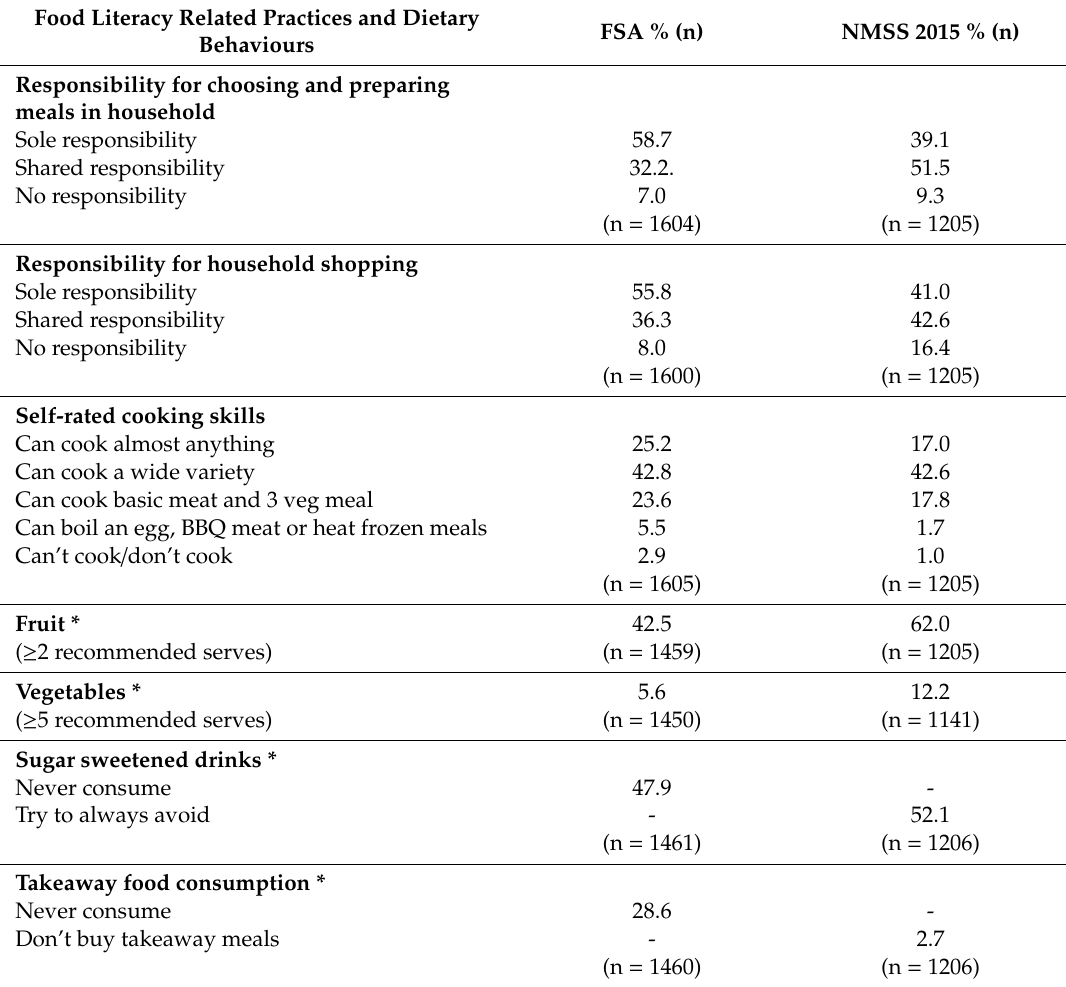
Table 2. Food literacy related practices and dietary behaviours compared to Western Australian Department of Health’s Nutrition Monitoring and Surveillance Survey